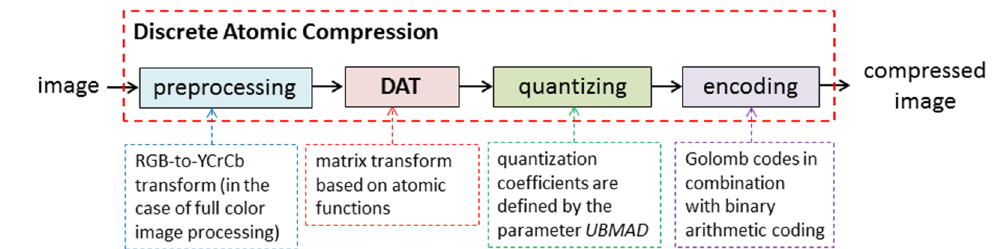
Figure 1. Discrete atomic compression of digital images.